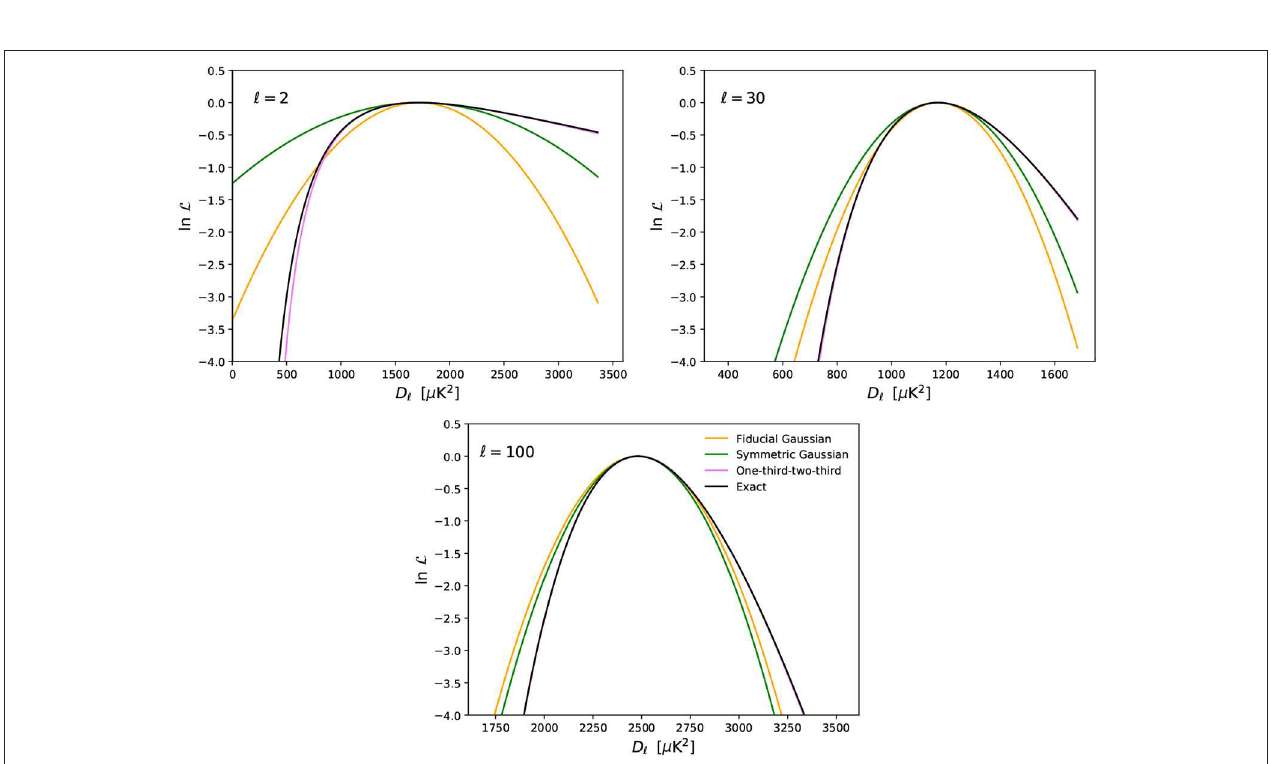
FIGURE 2 | Comparison of some of the likelihood approximations for different multipole regimes, as marked in the plots, where the x-axis corresponds to D ℓ ℓ ( ℓ 1) C ℓ / (2 π = +